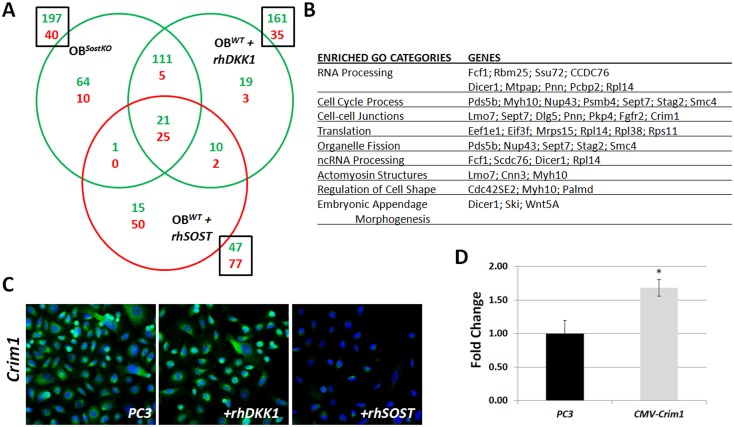
Molecular changes in invasive PC3 cells.A, microarray analyses of PC3 cells co-cultured with OBSostKO, OBWT+ rhDKK1, and OBWT + rhSOST as compared to monocultures; overlay representation of upregulated (green) and downregulated (red) genes. B, representative list of upregulated transcripts. C, representative images of CRIM1 protein expression modulation by rhDKK1 and rhSOST; green (CRIM1), blue (DAPI). Results are expressed as fold change ± SEM. * P<0.5, ** P<0.1, *** P<0.01. D, PC3 transfected with a CMV-Crim1 expression vector were significantly more invasive then PC3 cells (p-value 0.006).